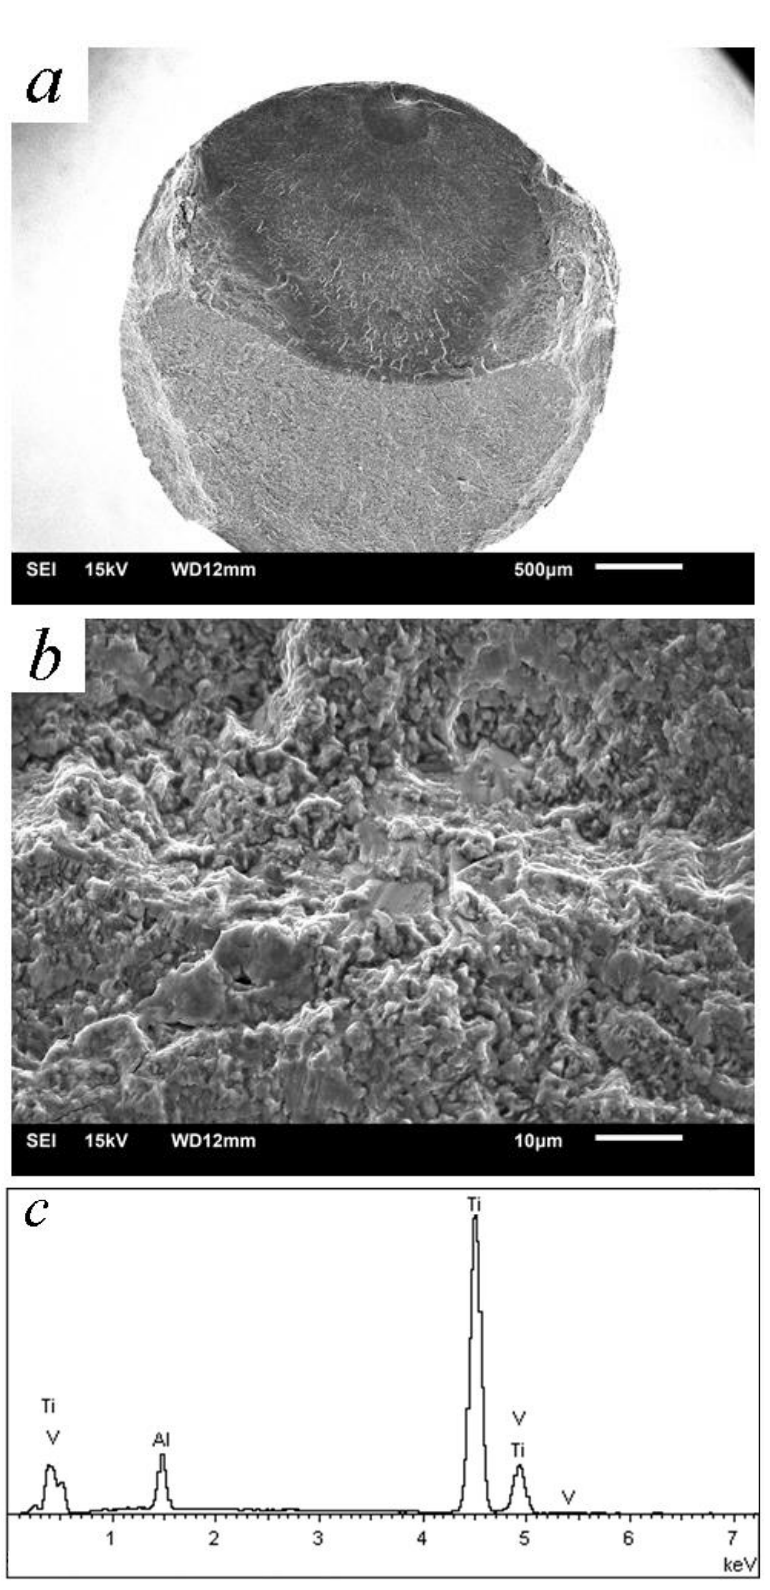
Figure 8. Fracture surface of TC4 subjected to UI treatment (720 MPa, 4.36 × 10 6 cycles): ( a ) overall view of the fracture surface; ( b ) crack initiation with facets; ( c ) EDX analysis of crack core.